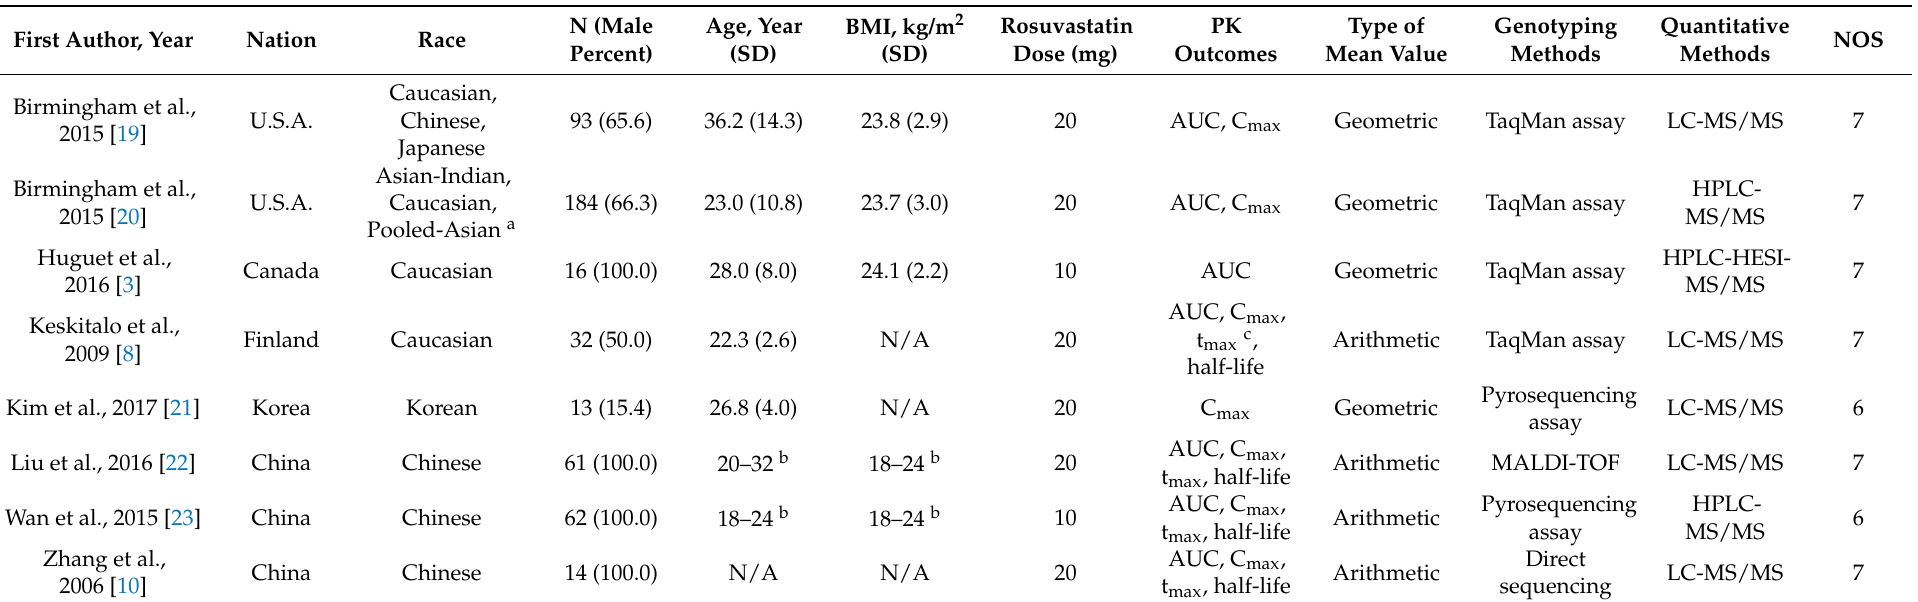
Table 1. Characteristics of the studies